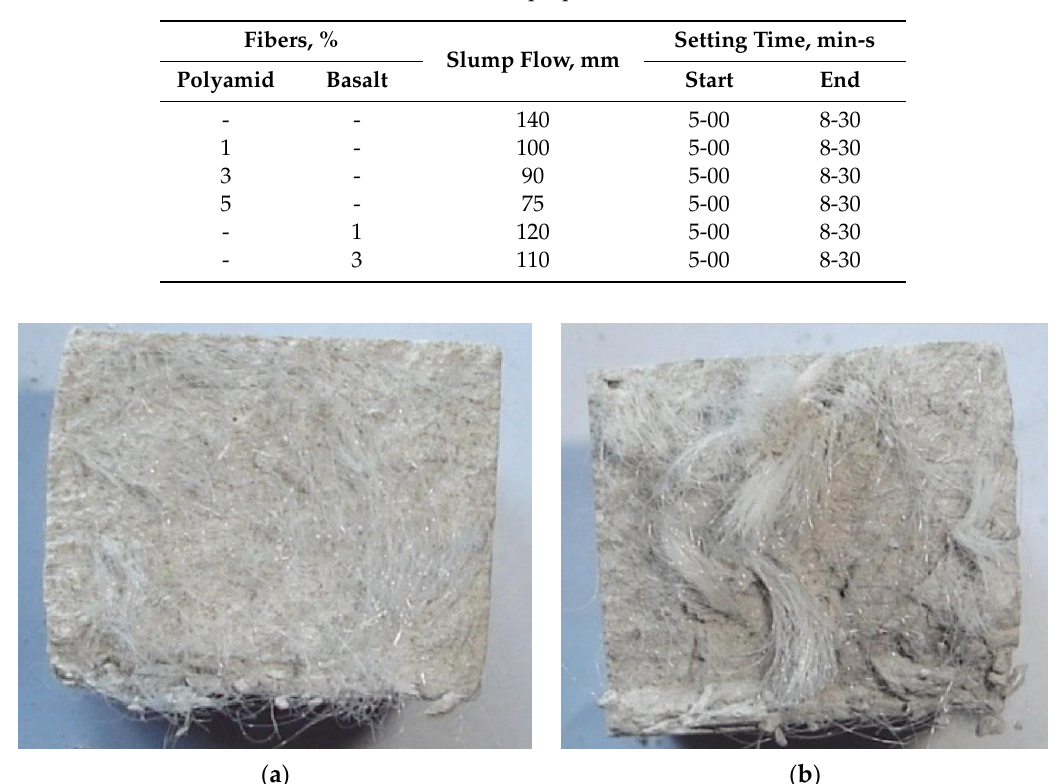
Figure 9. Uniform ( a ) and uneven ( b ) distribution of polyamide fiber in hardened GCB-FA specimens.